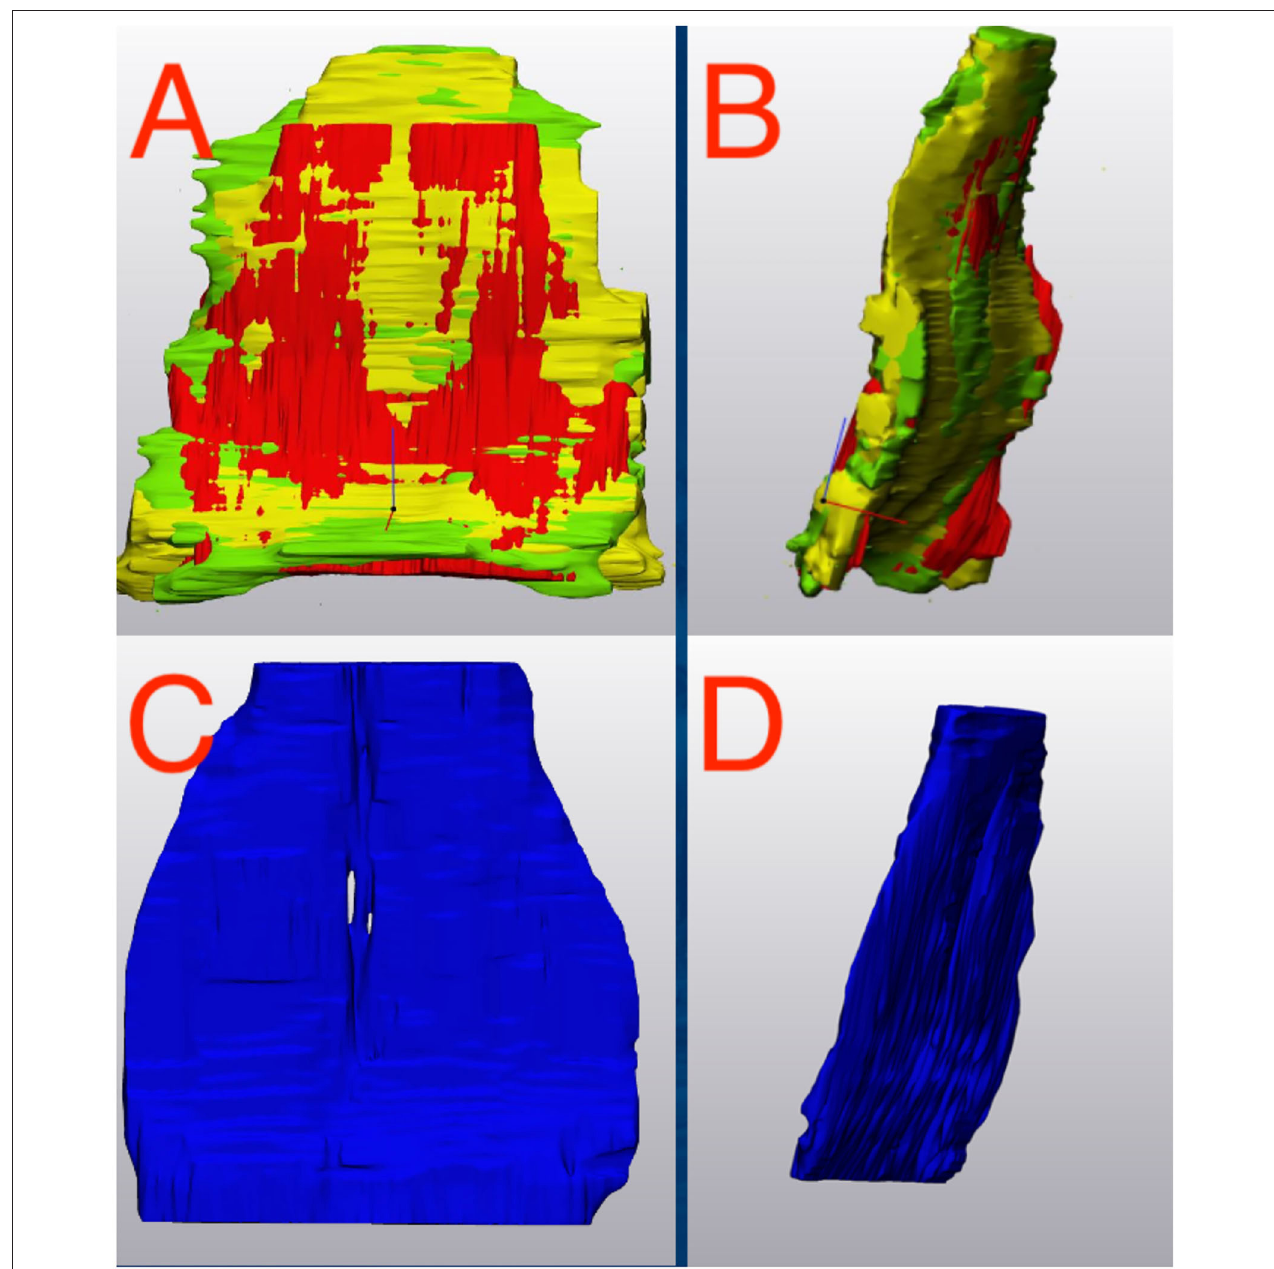
FIGURE 1 | Deep Digital Flexor Tendon Segmentation. (A,B) The three segmentations (axial, sagittal and dorsal) are imported into a 3D manipulation program. (A) Dorsal view. (B) Sagittal view. A Boolean intersection is performed to select only the common components of all three views before a wrapping and smoothing algorithm is applied. (C,D) The final representative tendon used for analysis. (C) Dorsal view. (D) Sagittal view. Top of the image represents the proximal aspect of the tendon.